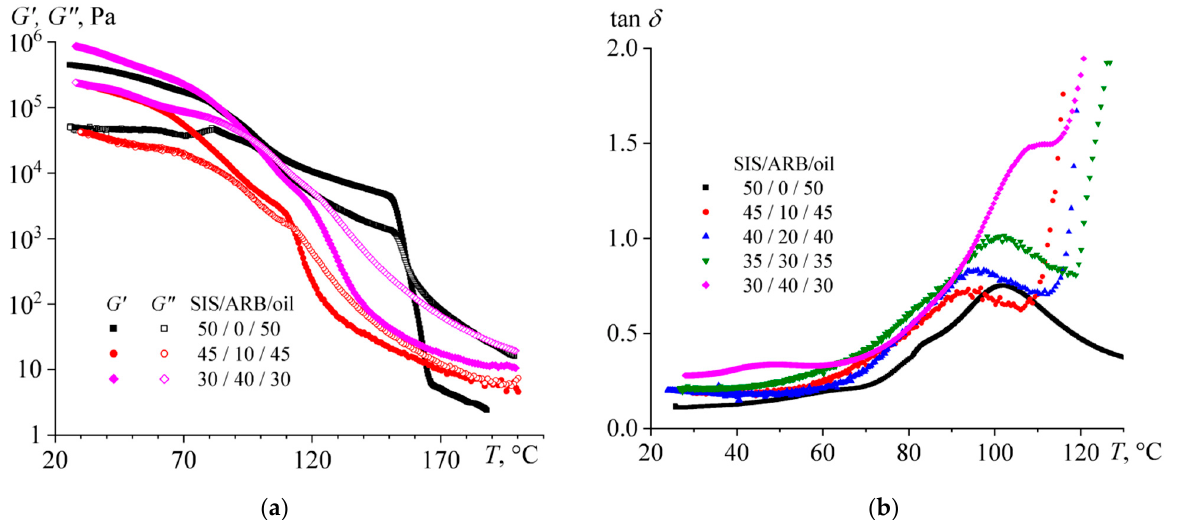
Figure 3. Temperature dependences of ( a ) storage and loss moduli and ( b ) loss tangent for triple mixtures containing different concentration of asphaltene/resin blend (ARB) and an equal ratio be ‐ tween styrene ‐ isoprene ‐ styrene triblock copolymer (SIS) and naphthenic oil.